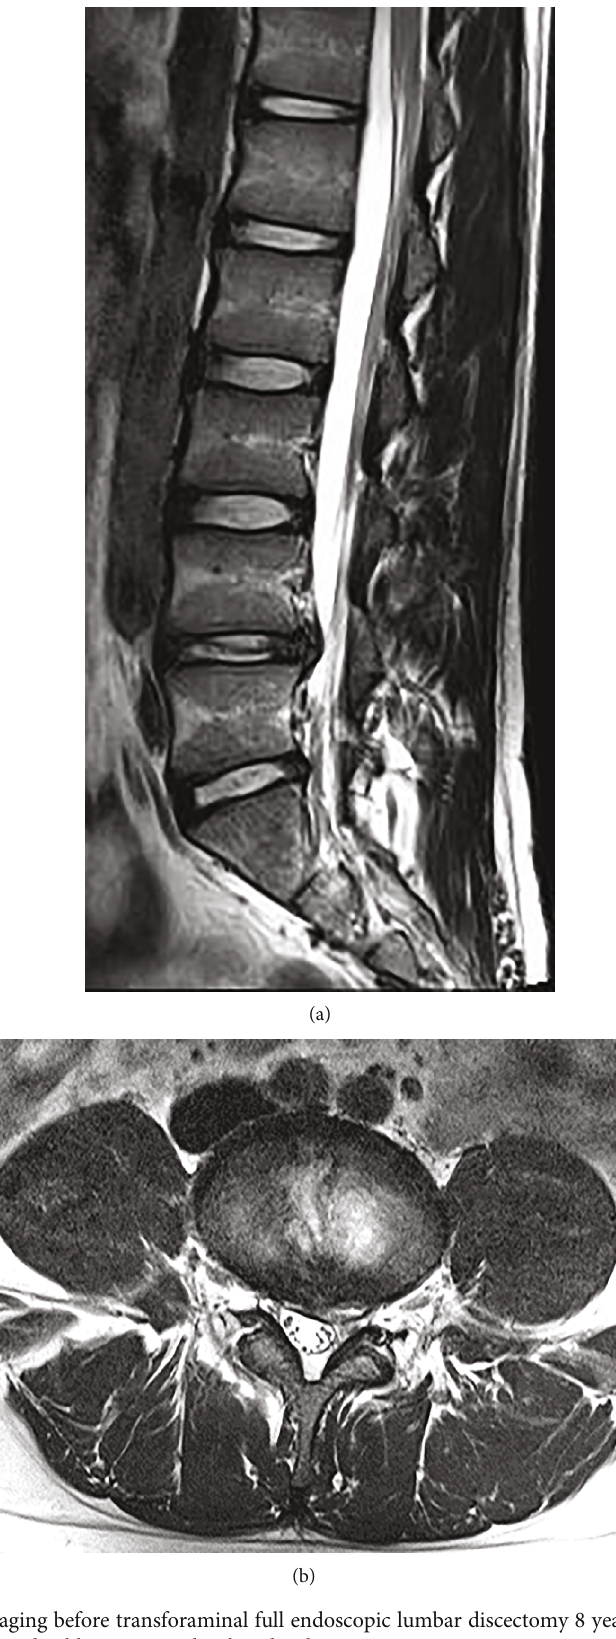
Figure 1: Magnetic resonance imaging before transforaminal full endoscopic lumbar discectomy 8 years ago. A (a) sagittal section and (b) horizontal section of the L4/5 showed subligamentous lumbar disc